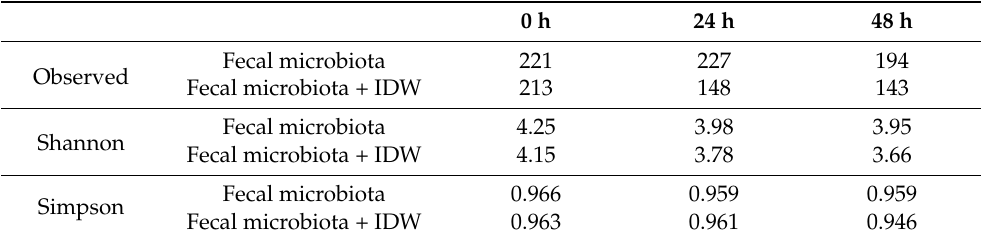
Table 2. Different alpha diversity indices (Observed, Shannon, and Simpson) during the fecal fermentations in the absence or presence of the intestinal-digested wine (IDW).